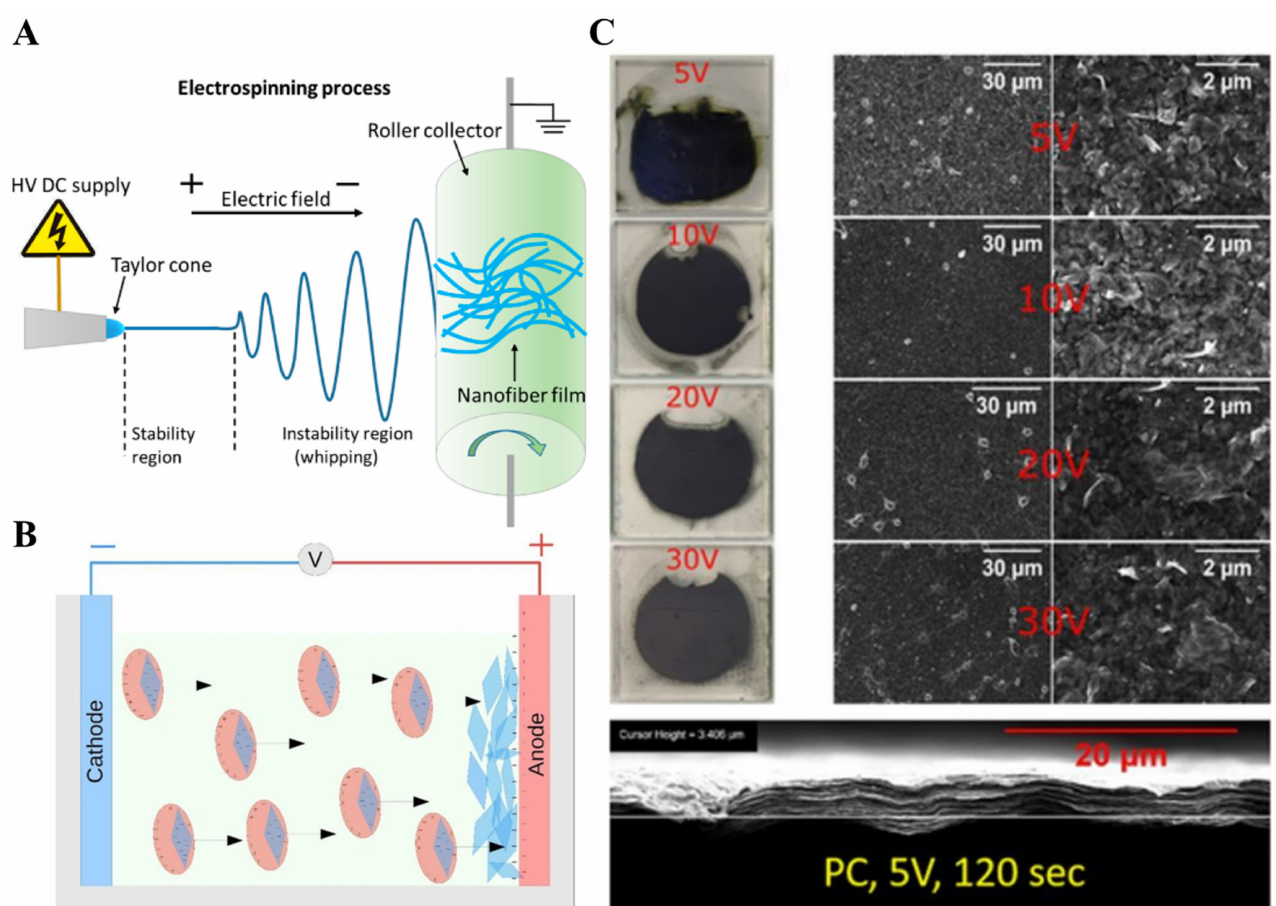
Figure 4. ( A ) Electrospray; ( B ) Electrophoretic method for the fabrication of Ti 3 C 2 T x films; and ( C ) SEM images of the Ti 3 C 2 T x formed under different voltage conditions for 600 sec each in water and polypropylene carbonate suspension. (reproduced with permission [74]. Copyright 2021, MDPI) (reproduced with permission [75]. Copyright 2017, IOP